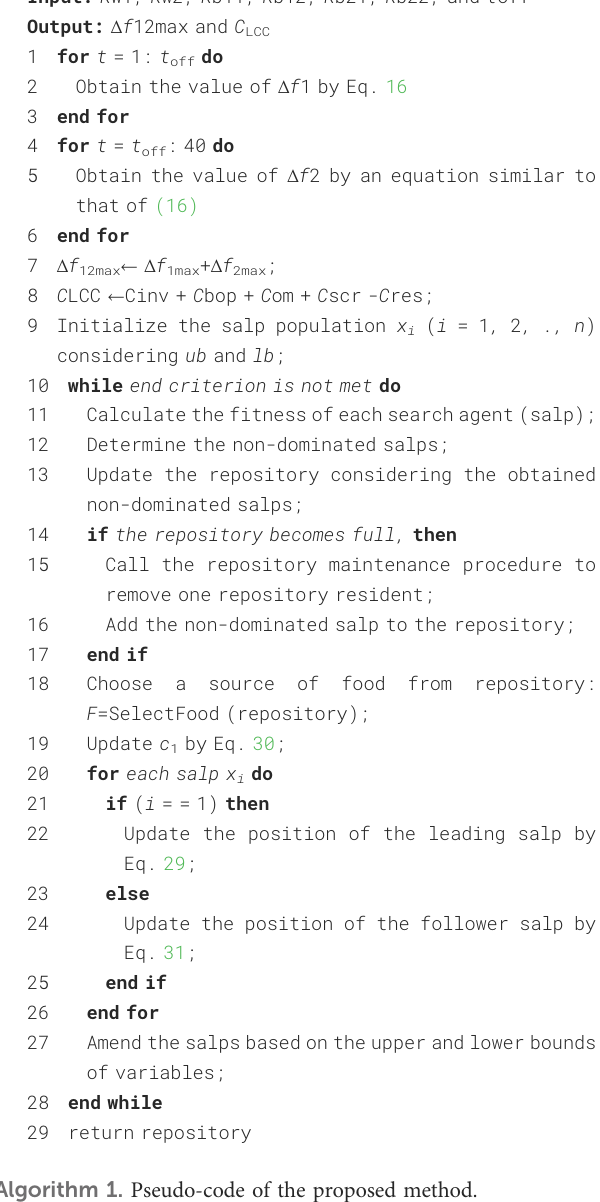
Algorithm 1. Pseudo-code of the proposed